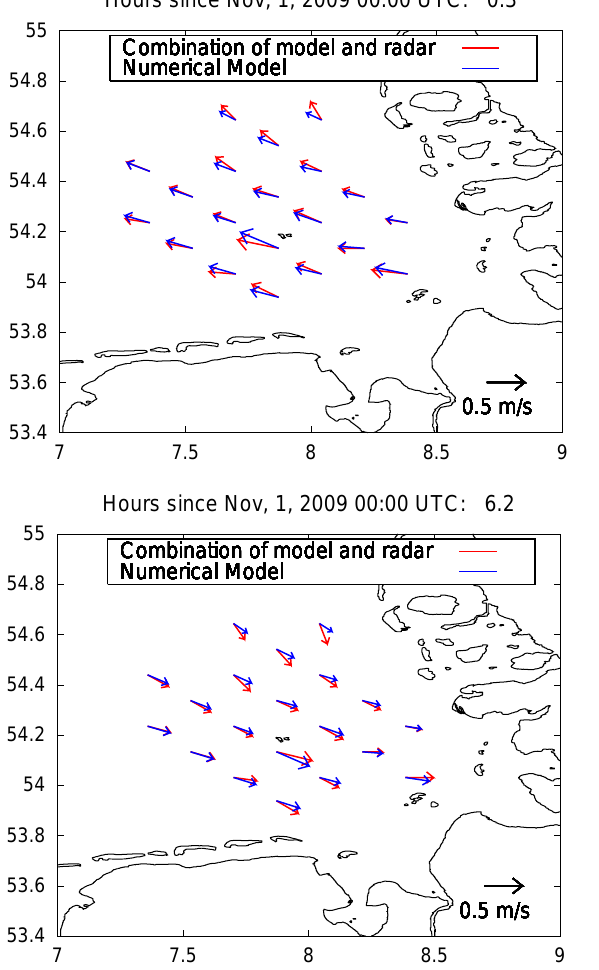
Fig. 11. Comparison of original current vectors (blue) from the F IG . 11. Comparison of original current vectors (blue) from the GETM model with analysed numerical model with analysed current vectors obtained by combi- current vectors obtained by combination with radial componentsmeasured by the HF radar nation with radial components measured by the HF radar station at station at Wangerooge (red) for Nov 1, 2009, 00:00 UTC (left) and half a tidal cycle later Wangerooge (red) for 1 November 2009, 00:00UTC (top) and half (right). a tidal cycle later (bottom).